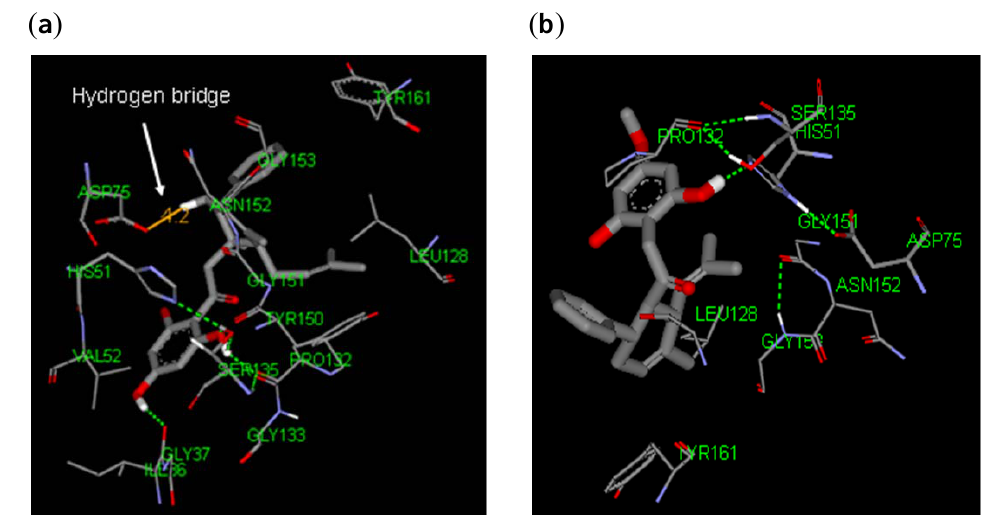
Figure 3. The binding site of the competitive inhibitors: ( a ) 4-hydroxypanduratin A;